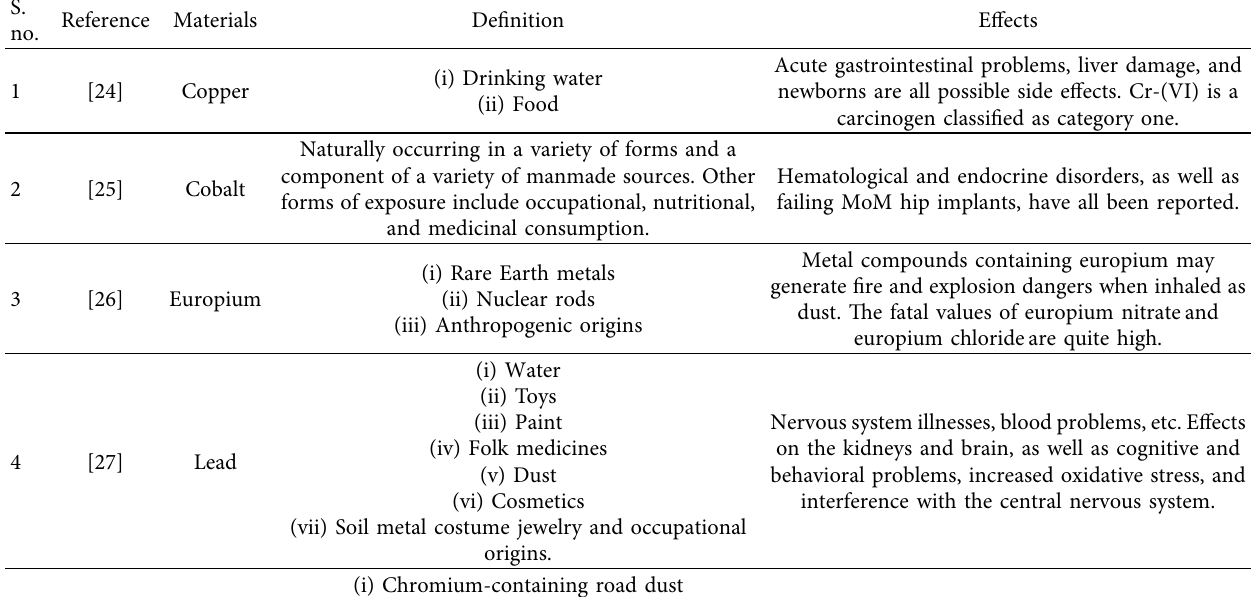
Table 1: Effects of heavy metals on human